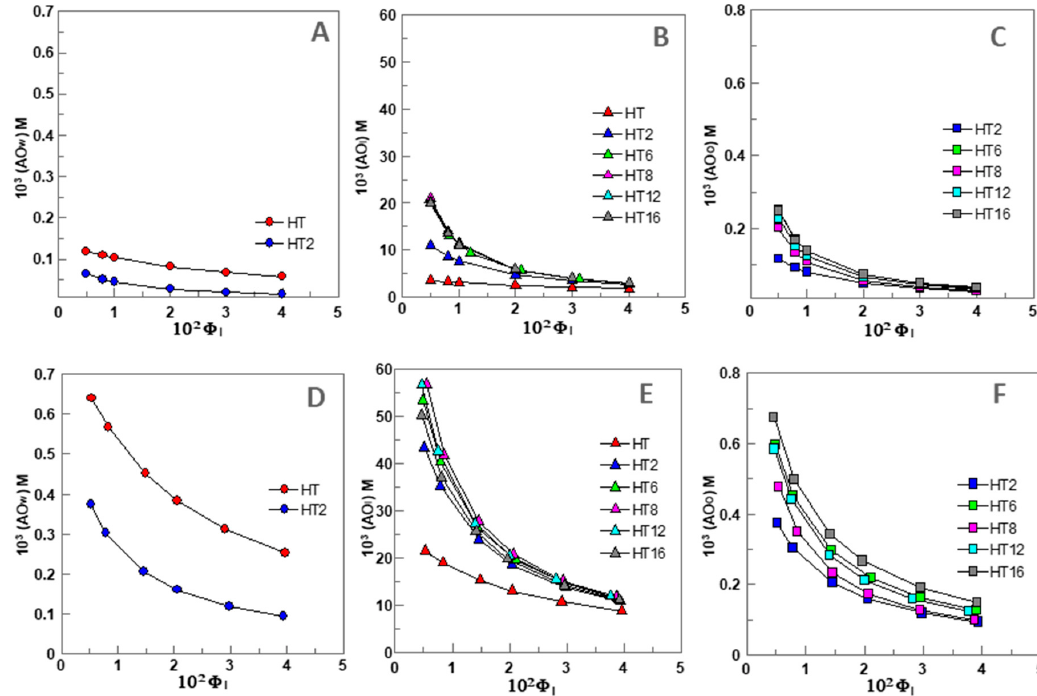
Figure 3. Variation of the concentration of HT and its derivatives (AO) in the different regions (W—water, I—Interface, O—oil) of 1:9 (O / W) nanoemulsions (( A – C ), respectively, [AO T ] = 0.125 mM) and 4:6 (O / W) emulsions (( D – F ), respectively, [AO T ] = 0.500 mM) composed of fish oil / 0.04 M citrate buffer, pH = 3.65 / Tween 80, T = 25 ◦